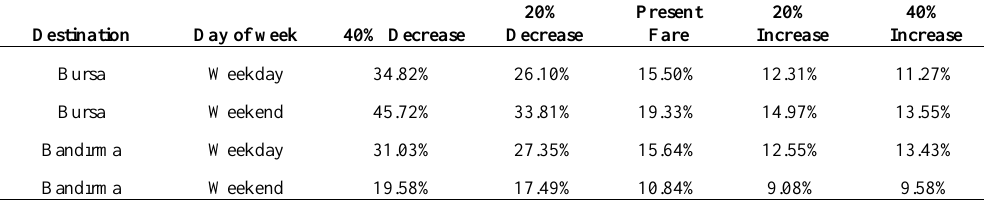
Table 4. Choice probabilities belonging to Bursa and Bandırma